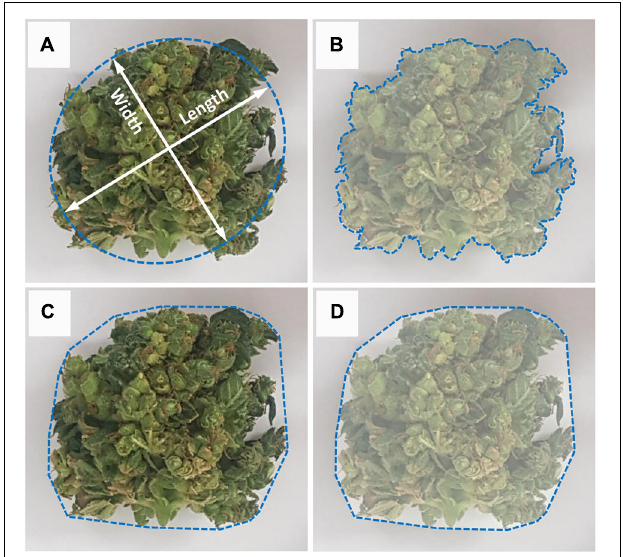
FIGURE 3 | Measurement methodology for image analysis of the inflorescence’s morphological parameters. (A) Measurement of inflorescence length (major axis) and width (minor axis). Major axis defined as the longest line that can be drawn across the inflorescence and width defined as the longest line that can be drawn through the object while maintaining a perpendicular intersection with the major axis, (B) Inflorescence area is defined as the area enclosed within the object perimeter, (C) Convex perimeter (Hull Perimeter) measures the surrounding perimeter that contains the inflorescence object, (D) Convex hull is the area enclosed within the inflorescence’s convex